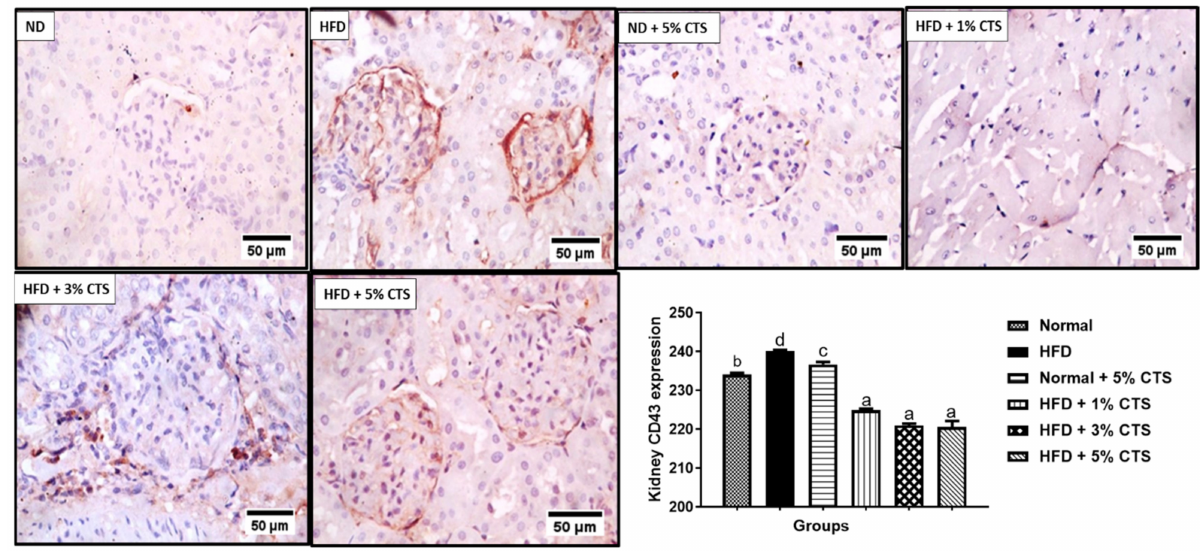
Figure 5. Photomicrograph of immune-histochemical expression of renal CD43. Values are expressed as mean ± SEM ( n = 3). Bars with distinct letters are statistically ( p < 0.05) different. ND–normal diet; HFD–high-fat diet; CTS–chitosan.